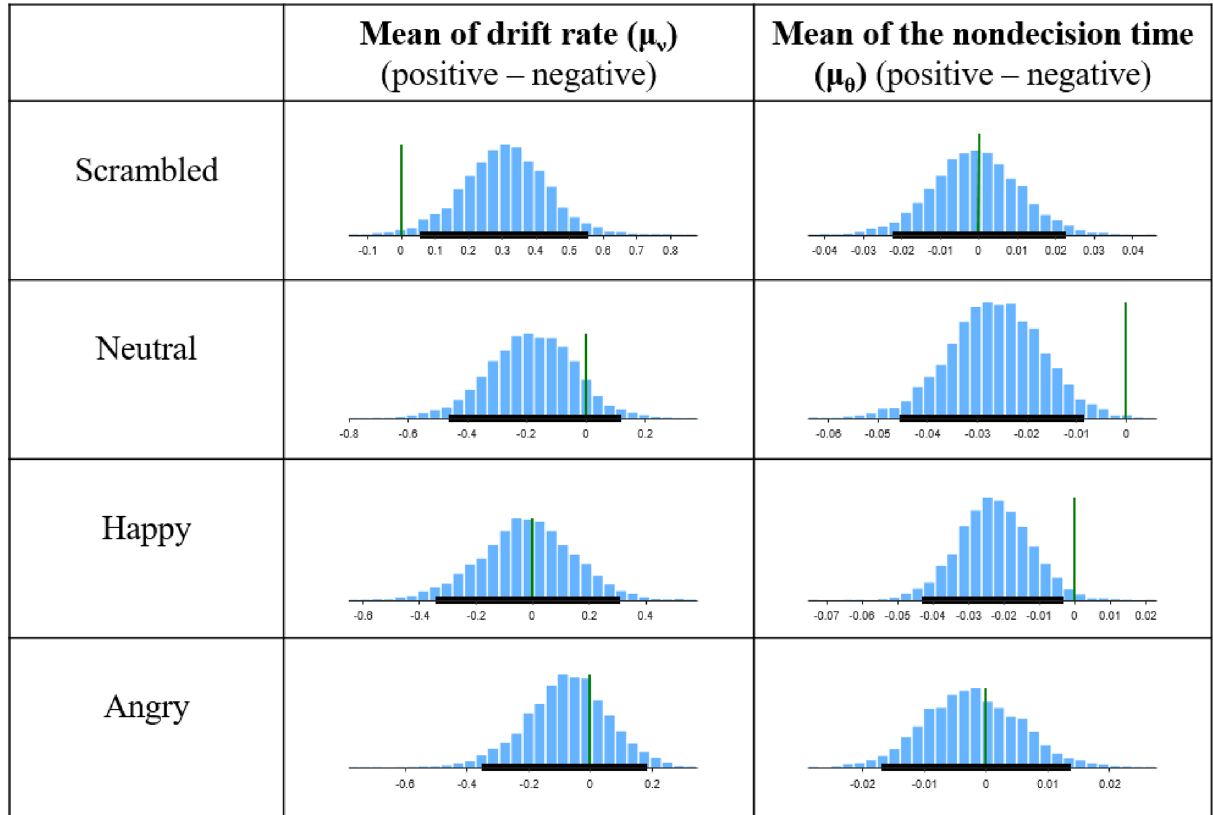
Figure 4. The posterior estimate differences in the mean of the drift rate and the mean of the nondecision time per